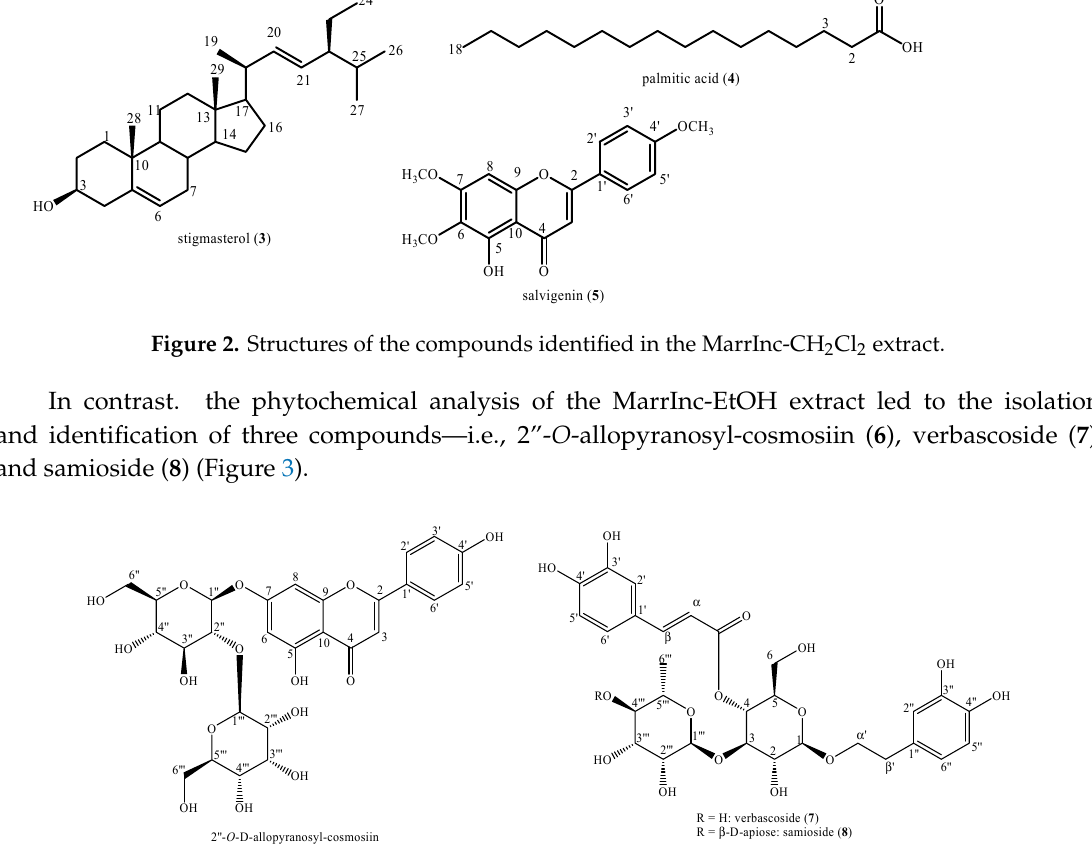
Figure 3. Structures of the compounds identified in the MarrInc-EtOH extract.